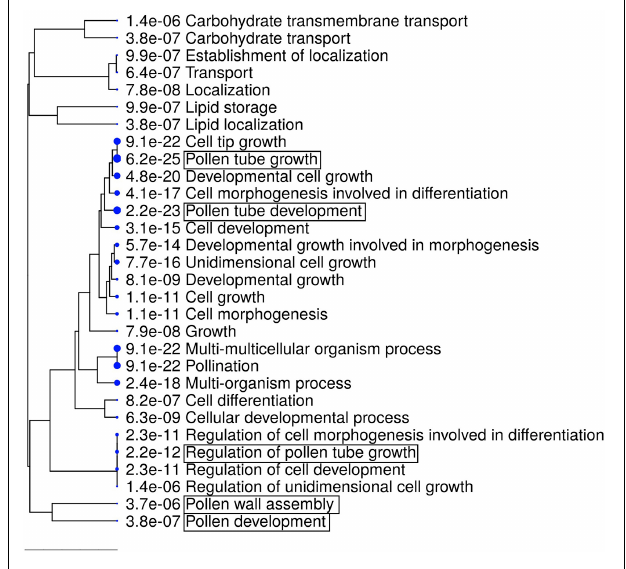
FIGURE 6 | GO enrichment analysis of downregulated DEGs (1736 genes). The top 30 hits on the GO list are shown in this figure, and all GO data are listed in Supplementary Table 4 . Hierarchical clustering tree summarizing the correlation among the significant pathways listed in the Enrichment tab. Larger dots indicate smaller P -values. GO terms containing “pollen” are highlighted by